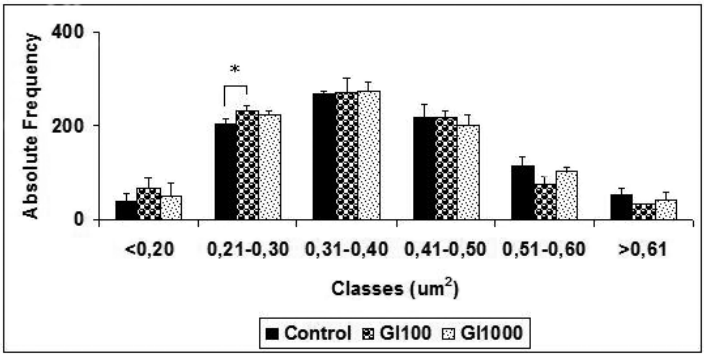
Fig. 4 – Histogram of the nucleus/body cell ratio in the myenteric neurons in the colon of Swiss male mice inoculated with 100 (IG 100 ) and 1,000 (IG 1000 ) trypomastigotes of T. cruzi Y strain at 75 dpi – days post inoculation and the non-infected controls (CG) (*) = (p <